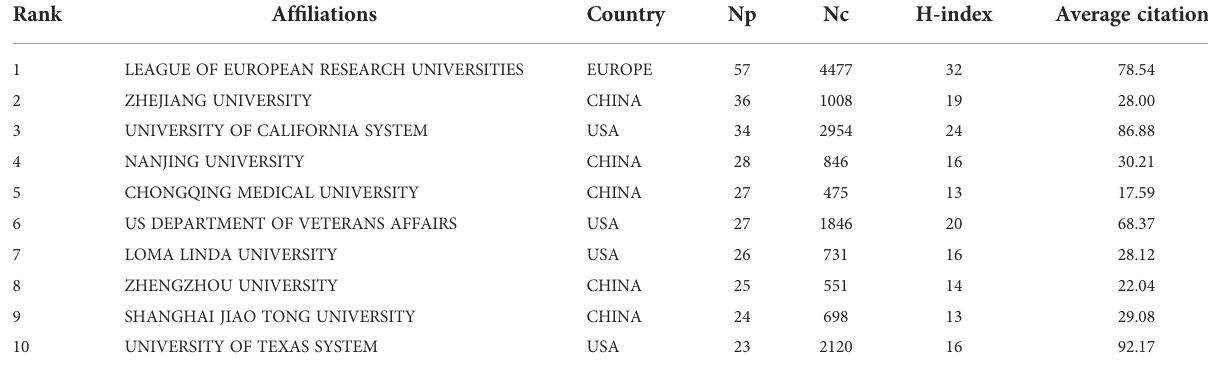
TABLE 2 Top 10 most productive af fi